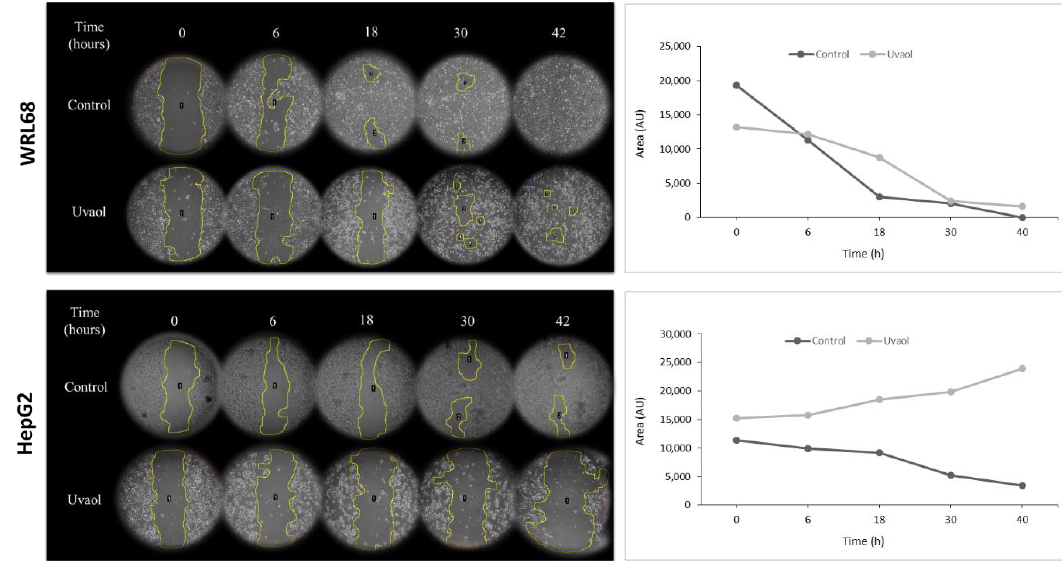
Figure 3. Representative image from wound healing assay of cells treated and no treated with uvaol at IC 50 concentration (0, 6, 18, 30 and 42 h) in WRL68 and HepG2 cells. In the graph, quantification of the cell-free region is showed during the time of wound healing assay (AU: arbitrary units).